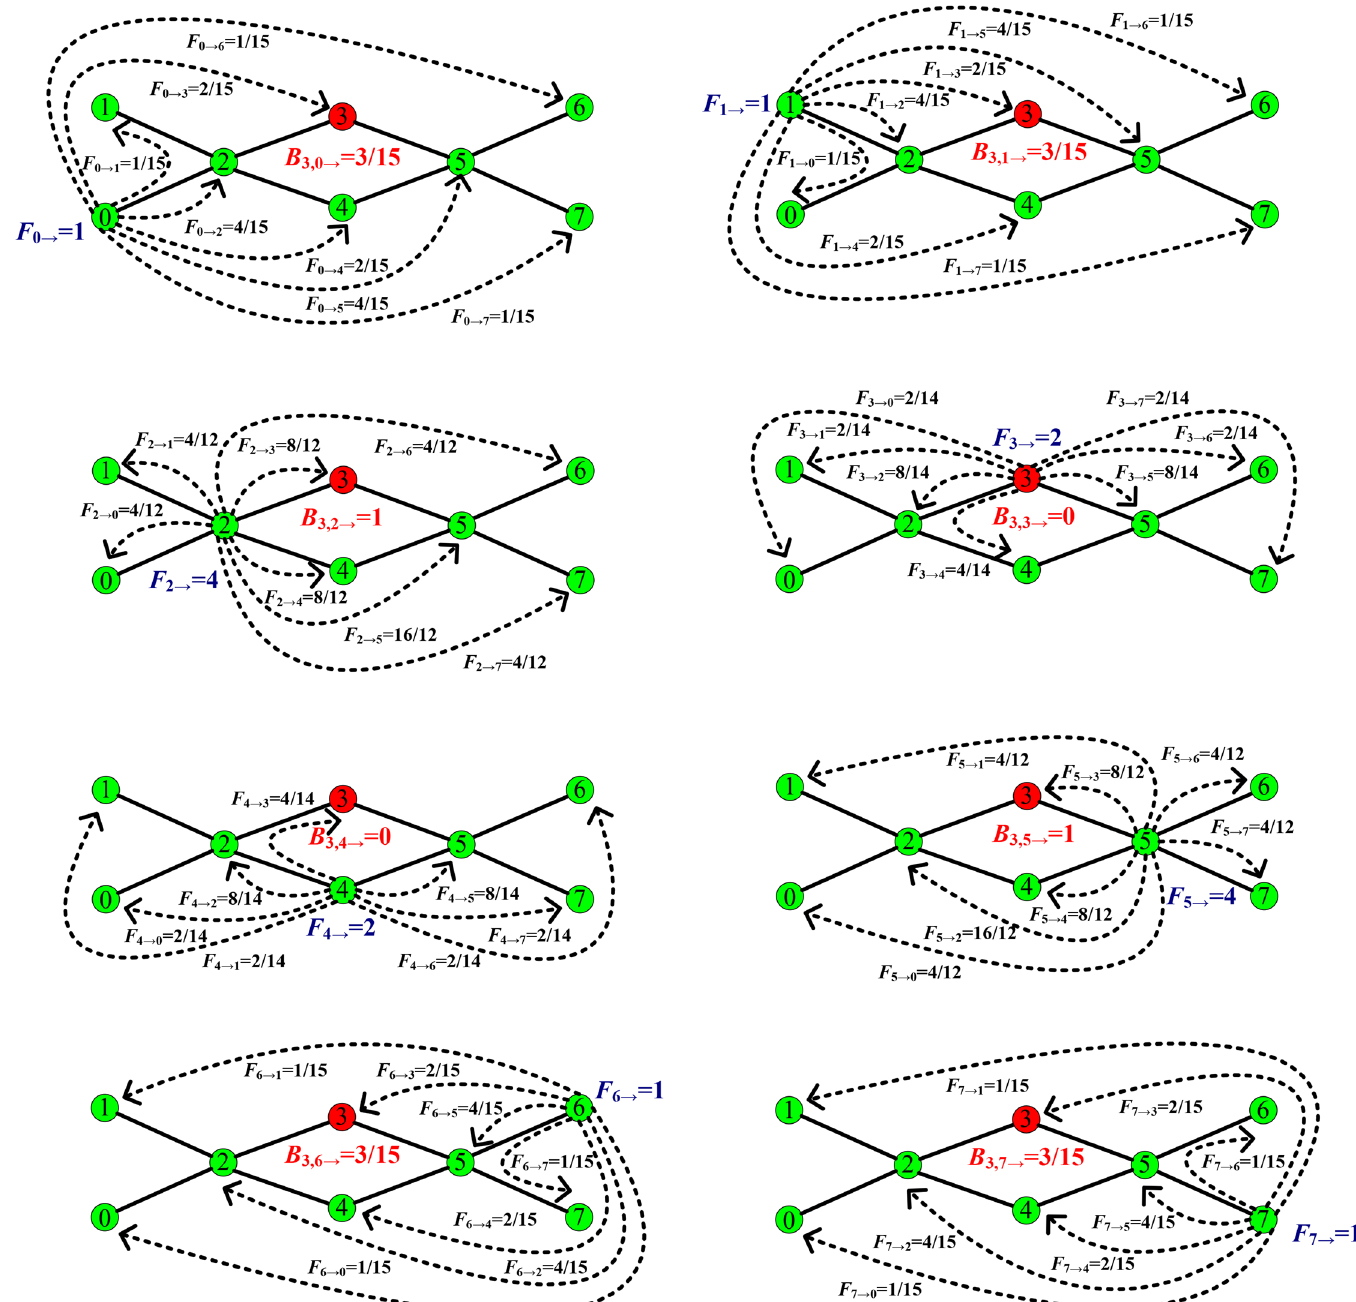
Fig 3. The scheme illustrates the calculating process of the initial load on a node in our new method. Compared with Fig 1, we here calculate the initial load on node 3. When α = 1, We can get that the loads generated by nodes 0, 1, 2, 3, 4, 5, 6, and 7 are F 0 = 1, F 1 = 1, F 2 = 4, F 3 = 2, F 4 = 2, F 5 = 4, F 6 = 1, and F 7 = 1, respectively. According to the preferential principle of the destination selection of the load transported, we can calculate the load exchanged between any two nodes. We can further get the loads passing through node 3 in the loads generated by every node are B 3,0 ! = 3/15, B 3,1 ! = 3/15, B 3,2 ! = 1, B 3,3 ! = 0, B 3,4 ! = 0, B 3,5 ! = 1, B 3,6 ! = 3/15, and B 3,7 ! = 3/15, respectively. Therefore, we can obtain that the total load B 3 transported by node 3 is 2.8, i.e., the initial load L 3 on node 3 is